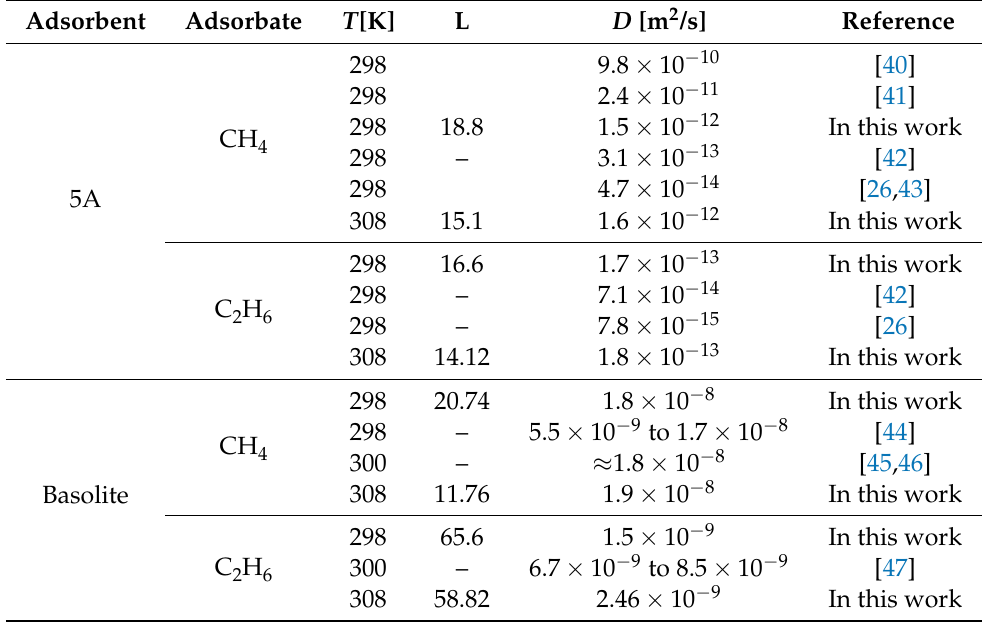
Figure 8. Experimental ZLC desorption curves of ethane on zeolite 5A at 298K, and a desorption rate of 5sccm and 20sccm, respectively. Table 2. Diffusivity of methane and ethane in zeolite 5A and Basolite ® C300 under kinetic